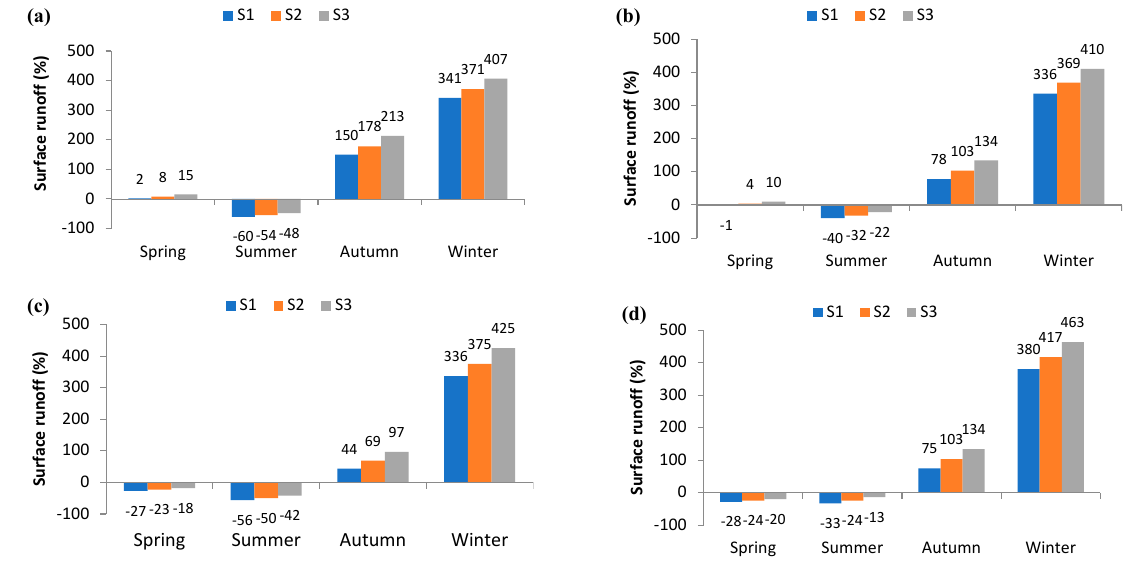
Figure 10. Seasonal surface runoff (%) projected for 2070–2100 in: ( a ) REMO4.5, ( b ) CLM4.5, ( c ) REMO8.5, and ( d ) CLM8.5.